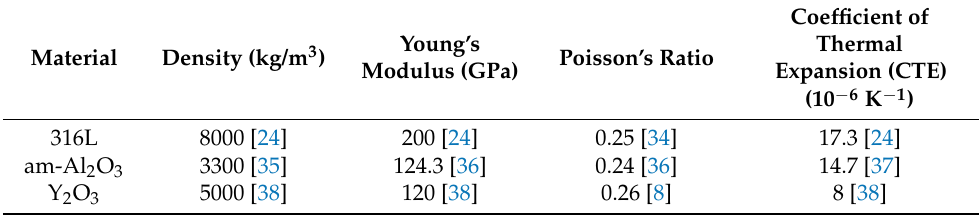
Figure 3. The geometry of the model: ( a ) laminated coating series 1 (with Y 2 O 3 top coat); ( b ) lami- nated coating series 2 (with Al 2 O 3 top coat). Table 2. Model